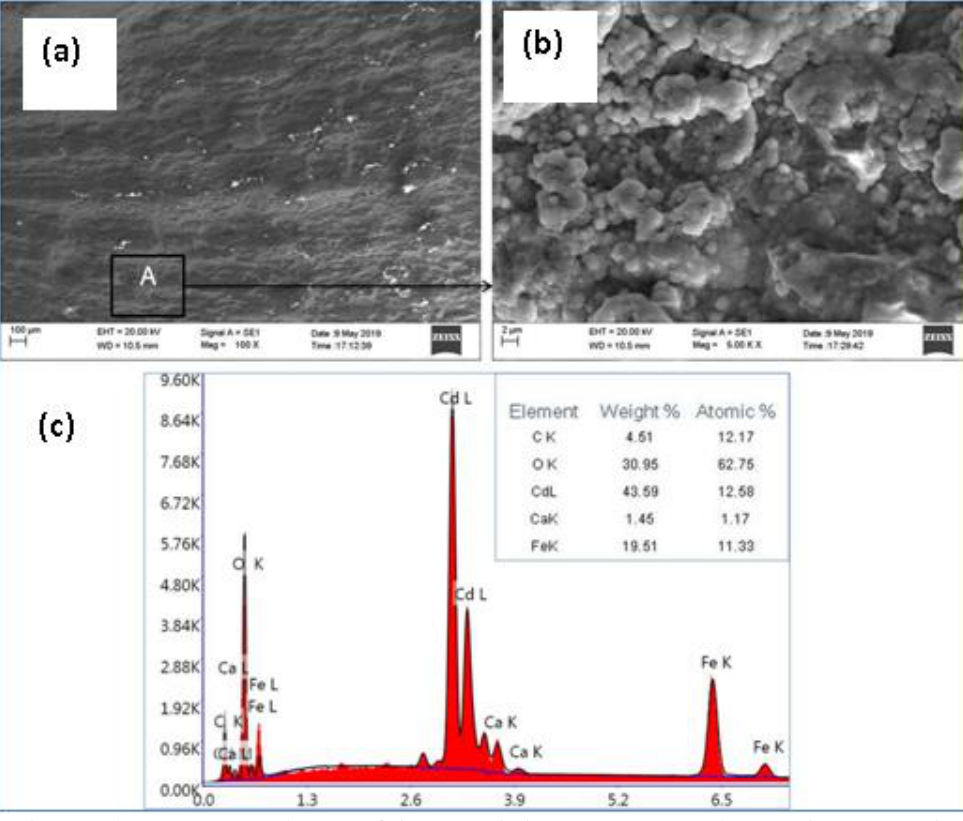
High magnification image of apparently clean region C is presented in Fig. 6. Cadmium has been found to exist as tiny round particles even here. Fig. 7 displays high magnification image of a typical area of region D in Fig. 5 (region 1 in Fig. 1c). The EDS patterns are taken from various locations (1, 2, 3 and 4) and results are presented in Fig. 7. Cadmium has been found even in some areas of this region (especially location 1), while few other areas reveal the presence of corrosion debris (locations 3, 4 in form of Fe-O) and base material (location